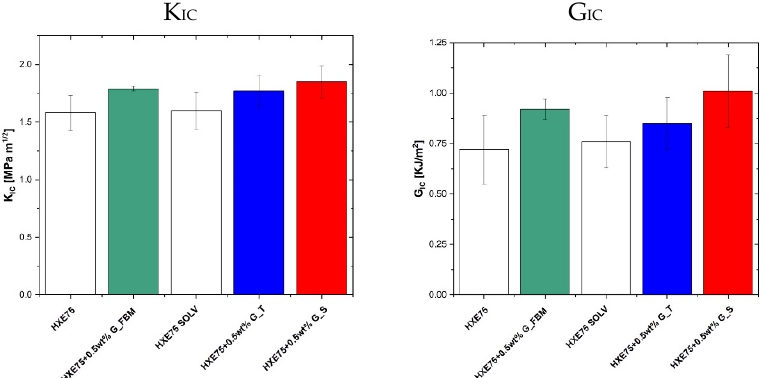
Figure 5. Fracture toughness results of the neat epoxy matrix and the GNP based nanocomposites.